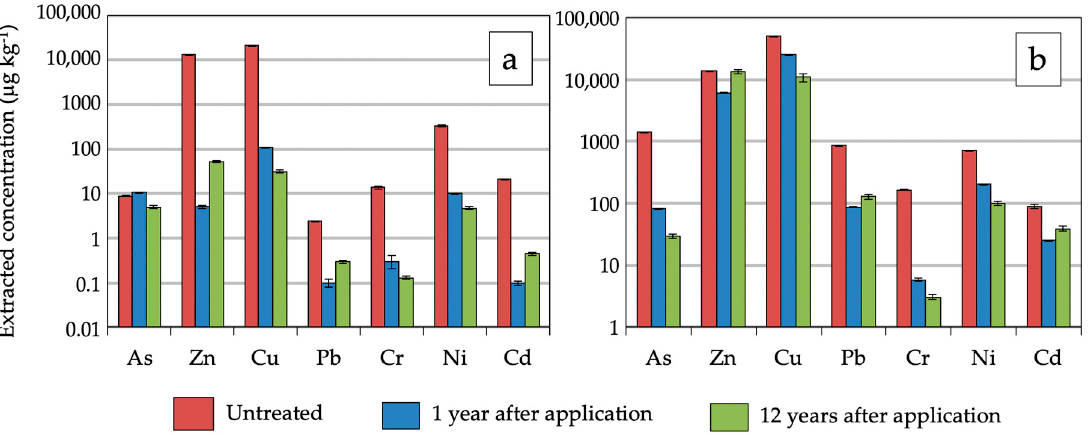
Figure 9. Figure 9. Bar chart comparing trace element availability before and after marble slurry waste appli- cation, at years one and twelve after soil amendment. ( a ) Water-extracted concentration; ( b ) EDTA- extracted